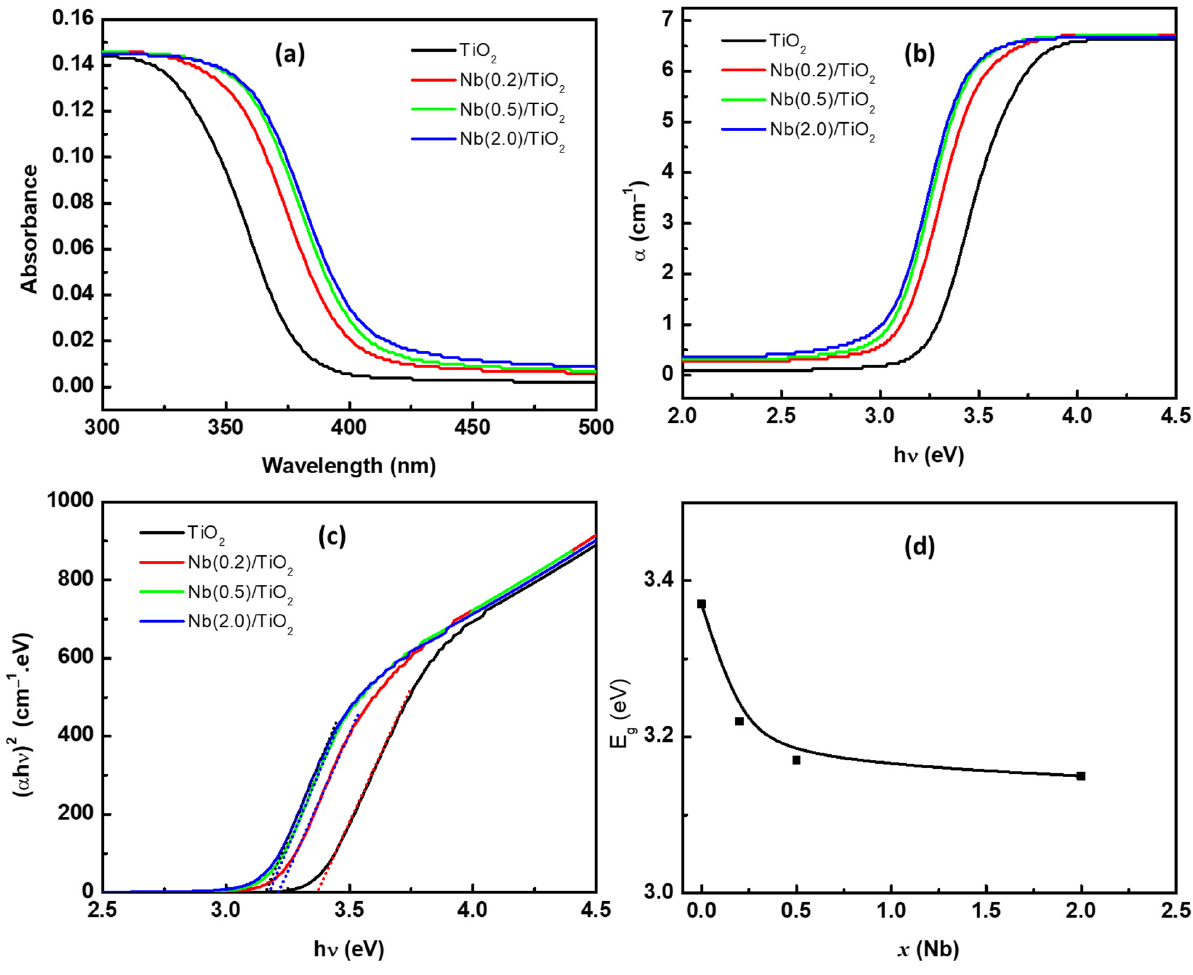
Figure 5. ( a ) t he absorbance spectra, ( b ) the absorption coefficient, ( c ) the Tauc-plot, and ( d ) the optical band gap of the Nb(x)/TiO 2 optical band gap of the Nb(x)/TiO 2 nanocomposites.